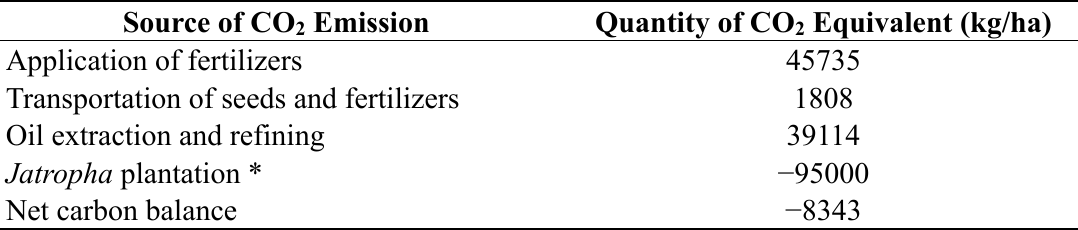
Table 3. The carbon balance of Jatropha biodiesel production.